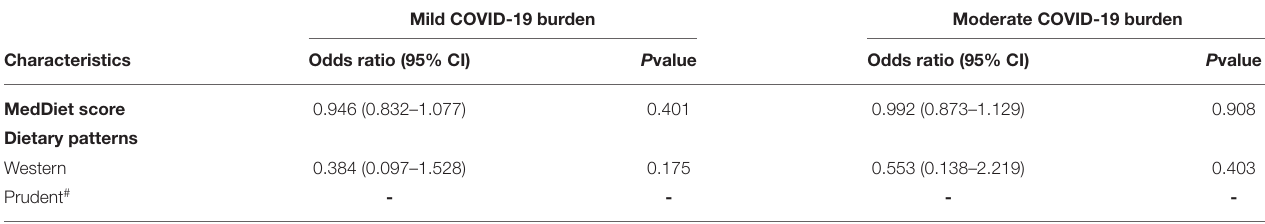
TABLE 9 | Multiple adjusted logistic regression for the association between the dietary intake and the burden of COVID-19. Mild COVID-19